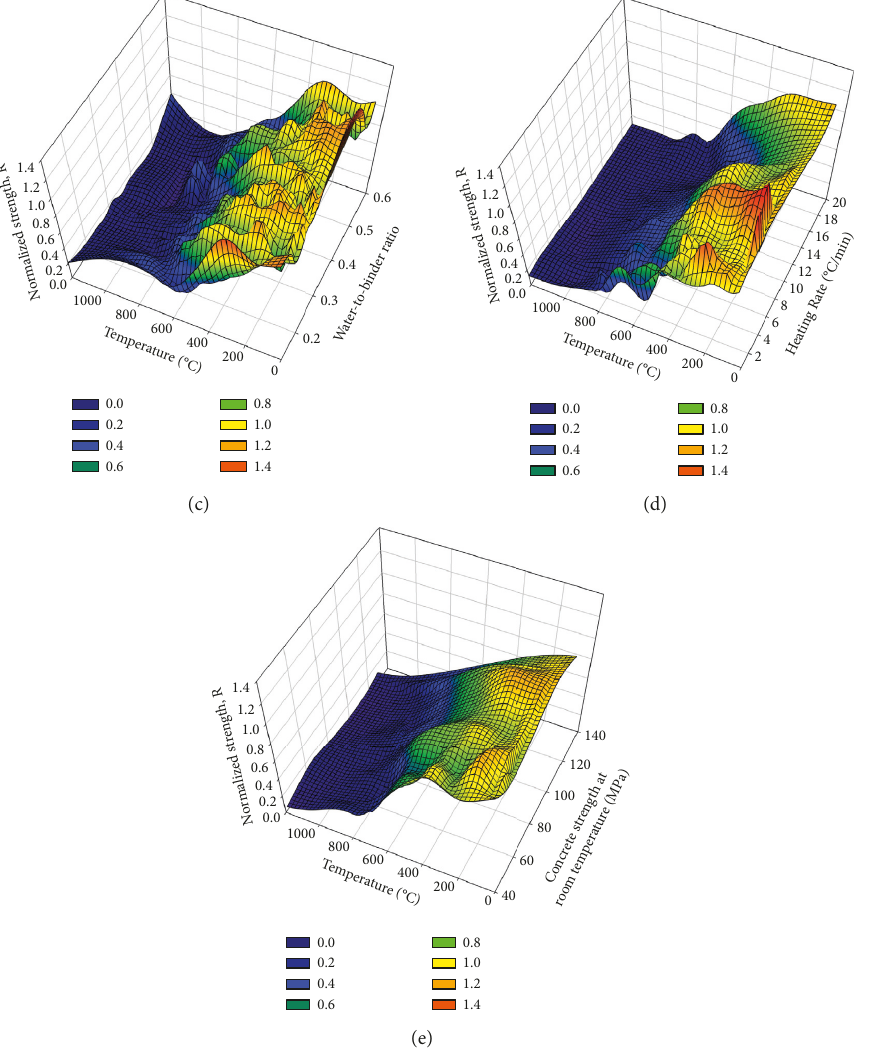
Figure 3: Normalized concrete strength as functions of exposure temperature and (a) type of coarse aggregate, (b) aggregate-to-binder ratio, (c) water-to-binder ratio, (d) heating rate, and (e) concrete strength at room